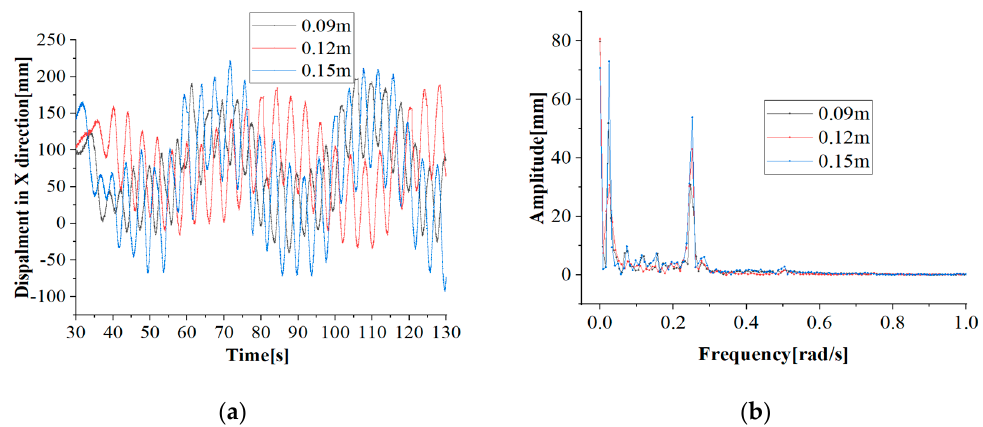
Figure 14. Surge response of the pedestal with different wave heights at 0.25 Hz. ( a ) Surge; ( b ) surge frequency domain curve.